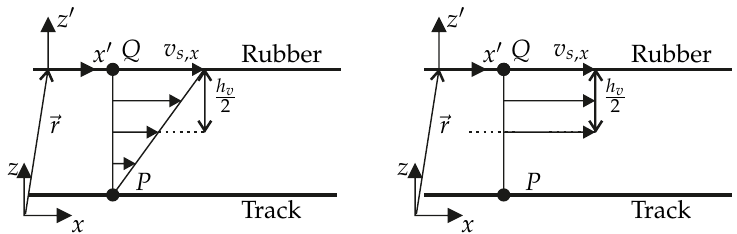
Figure 7. Velocity distribution over the water film height h v assuming a Poiseuille flow ( left ). Approximated binary velocity distribution with equivalent volume flow ( right